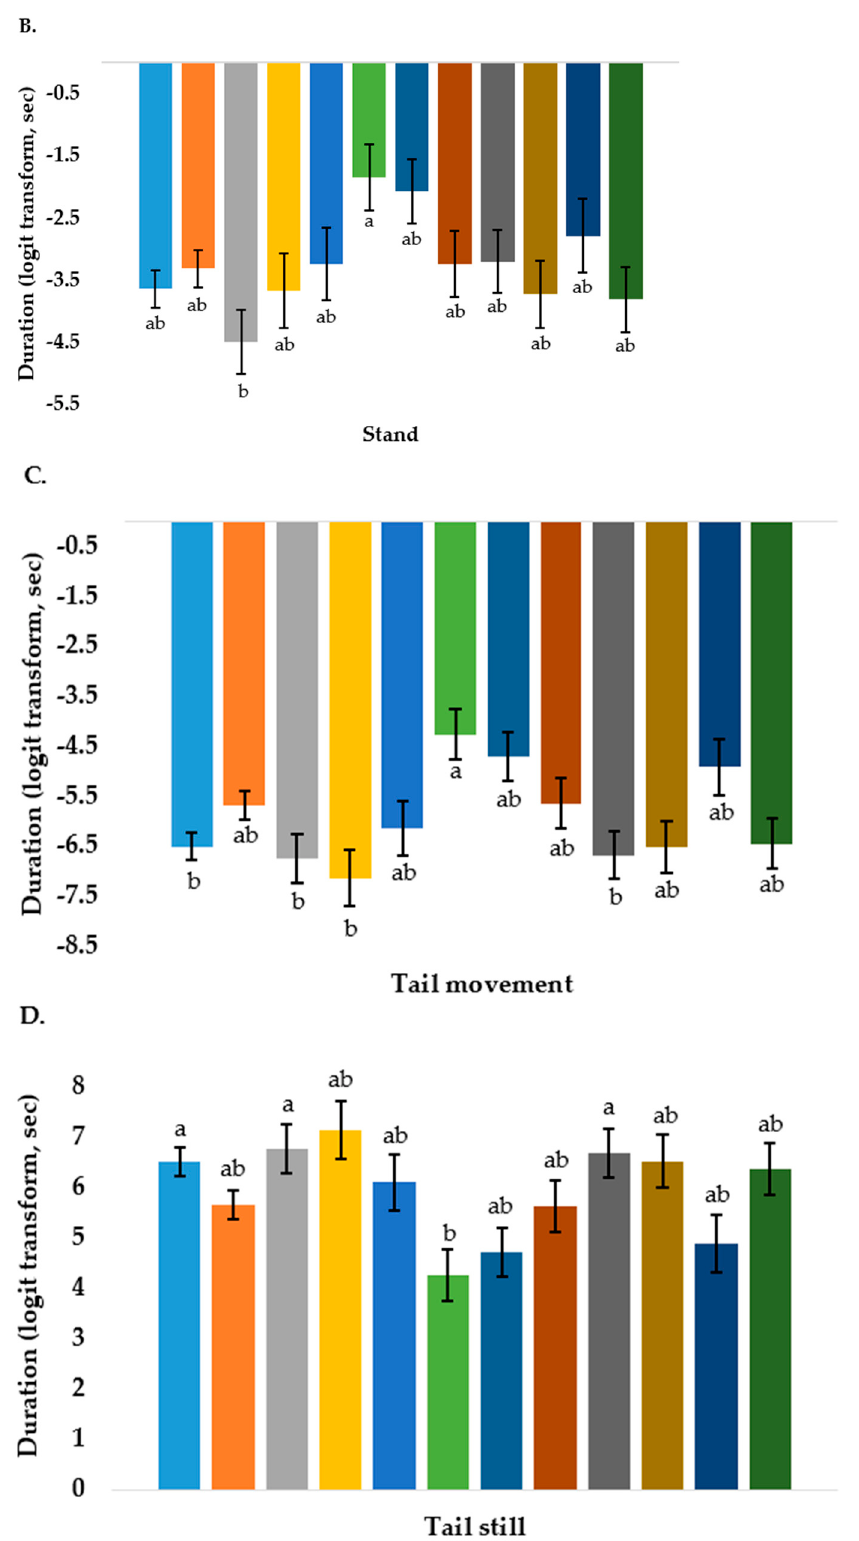
Figure 1. Duration of time (logit transform, seconds) dogs ( n =10) spent ( A ) lying down, ( B ) standing, ( C ) moving their tail and ( D )with their tail still when exposed to 10 songs, white noise and a control, for 10 min (600 s) over 10 days. Sharing different letters mean that significantly different from each other.